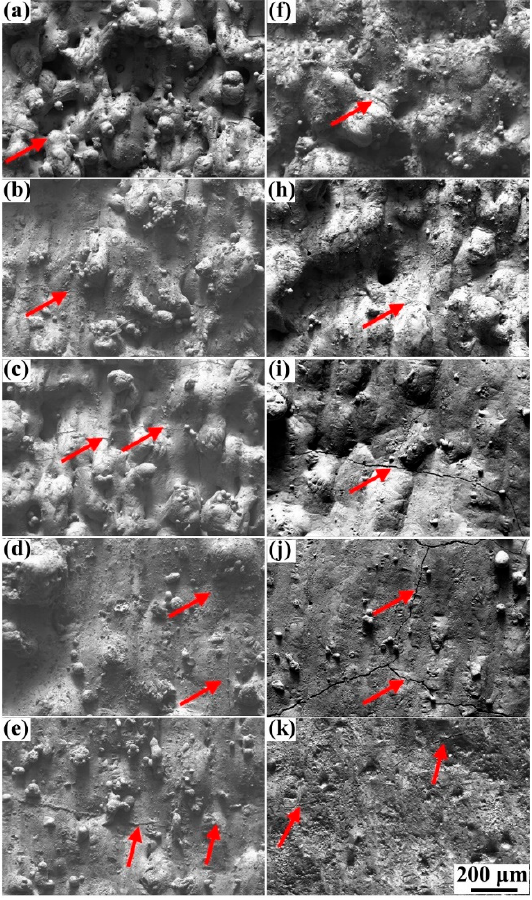
Figure 4. The high-magnification SEM pictures of the top surface morphology corresponding to Figure 3: ( a – e ) Scanning speed of 370 mm/s, laser power from 95 to 215 W; ( f – k ) scanning speed of 240 mm/s, laser power from 95 to 215 W.